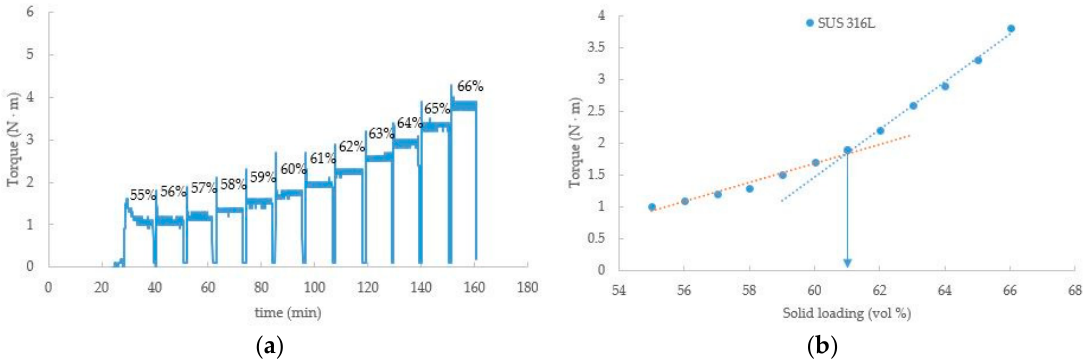
Figure 3. ( a ) Torque vs. time for finding critical solid loading, and ( b ) torque vs. solid loading using a torque rheometer. Table 4. Feedstocks with various polymethyl methacrylate (PMMA) space holder sizes (20, 50, 80 μ m) and their volume percentages.